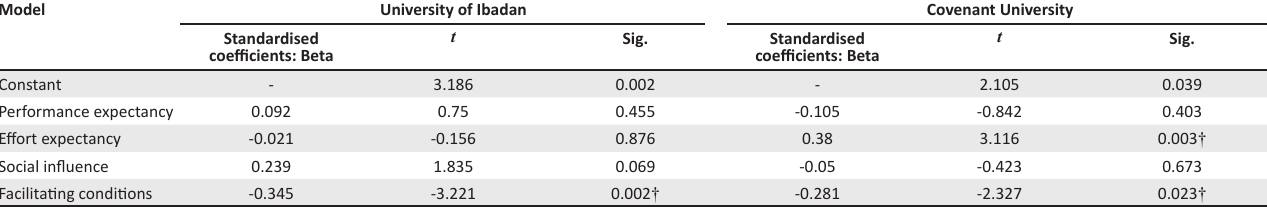
TABLE 3: Regression result of underlying success factors for information and communication technology use in teaching.